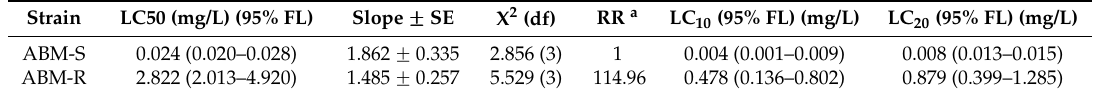
Table 1. Susceptibility of P. xylostella strains to abamectin treatment.